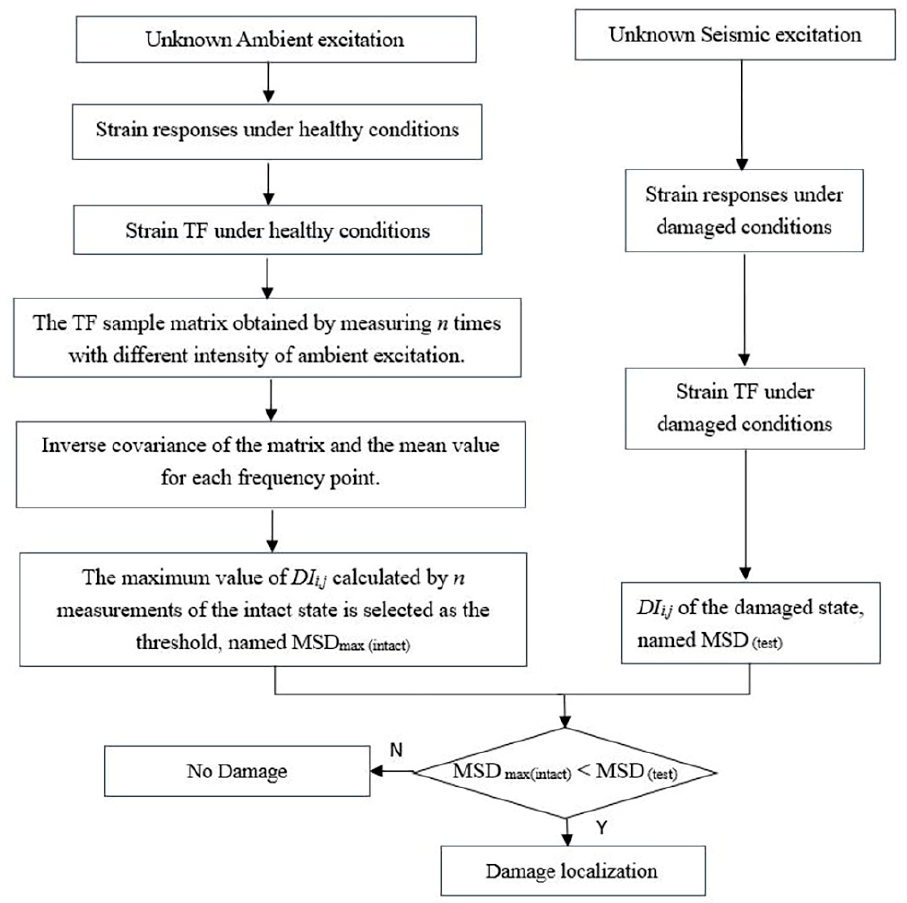
Figure 1. Flowchart of damage localization approach.